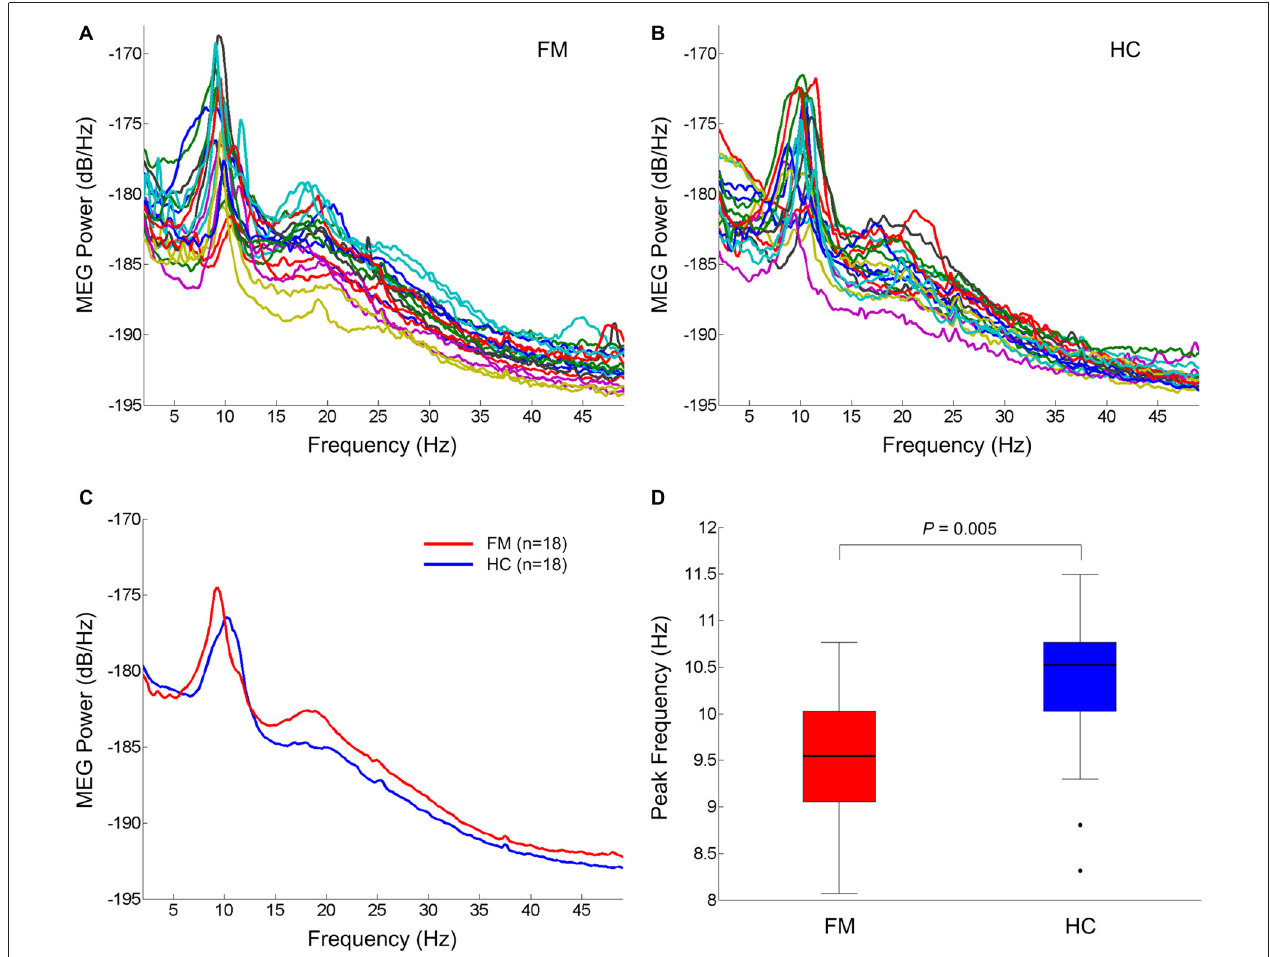
FIGURE 1 | Resting state oscillatory brain activity . Superposition of individual mean power spectra of spontaneous brain activity recorded from all MEG gradiometer sensor pairs in FM patients (A) and HC subjects (B) . Grand averaged power spectra of FM patients (red) and HC subjects (blue) (C) . Box plots of the dominant peak frequency in the alpha band (D) . On each box, the horizontal line is the median and the edges of the box are the 25th and 75th percentiles. Whiskers extend to the highest and lowest values within 1.5 times the interquartile range. The filled circles represent outliers. P value was determined by the two-tailed t -test for independent samples. FM, fibromyalgia; HC, healthy